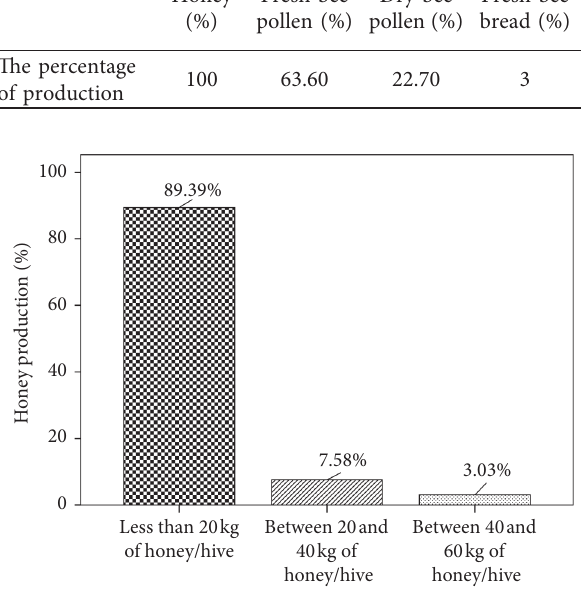
Figure 5: Annual honey production per hive.